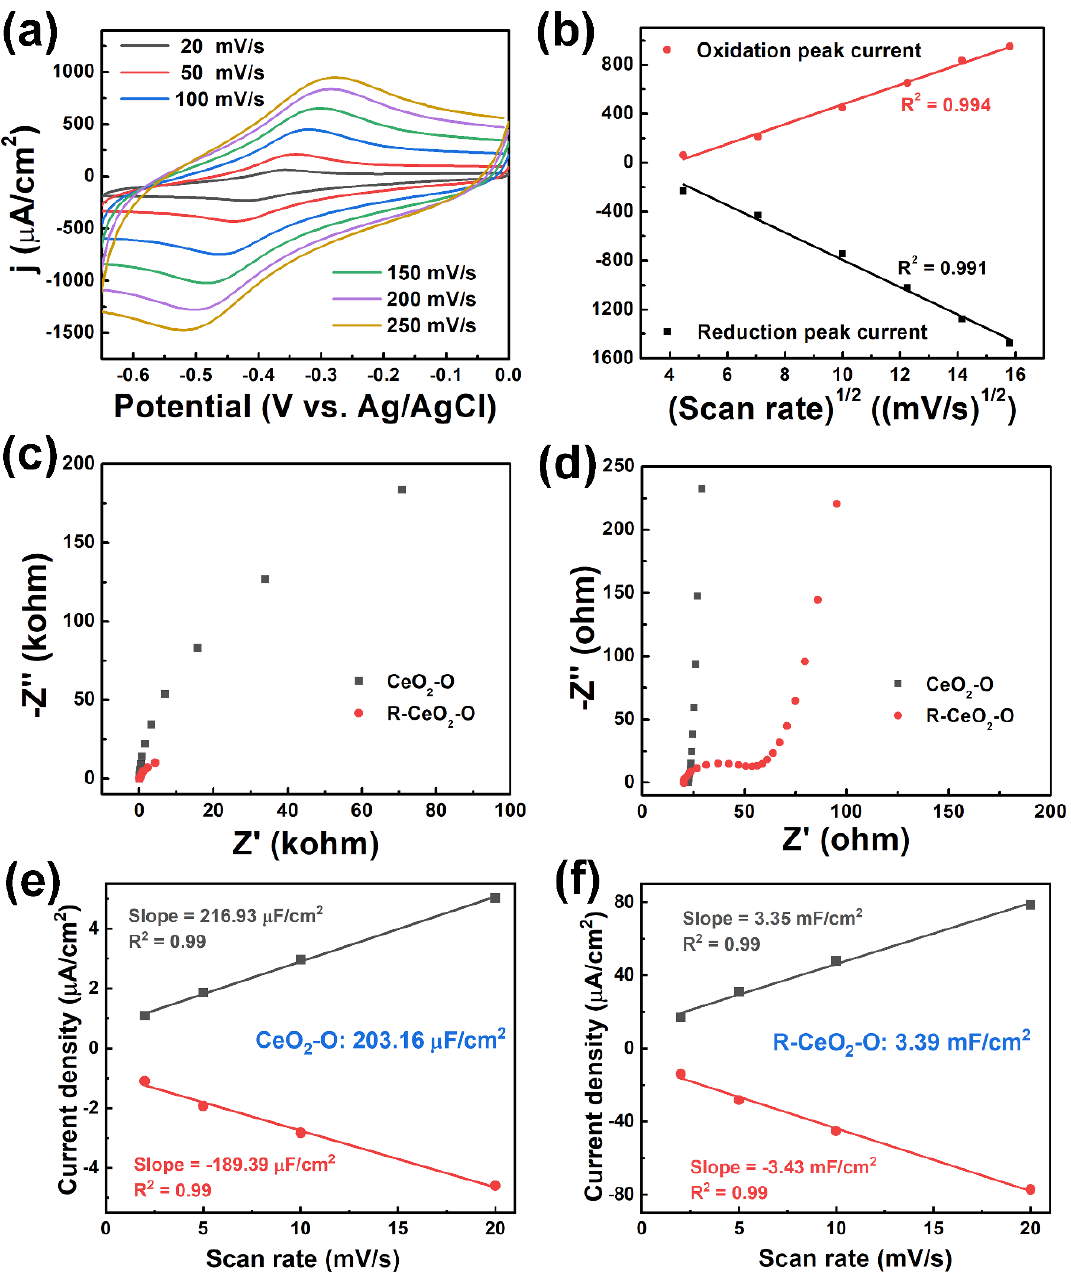
Figure 5. ( a ) CV scans of R-CeO 2 -O in 0.1 M PBS with 1 mM H 2 O 2 at different scan rate and ( b ) linear plots of peak current density versus square root of scan rate. Nyquist plots of CeO 2 -O and R-CeO 2 -O ( c ) in full range and ( d ) in high-frequency region. The corresponding linear plot (derived from Figure S6) of the capacitive currents of ( e ) CeO 2 -O and ( f ) R-CeO 2 -O vs. scan rates for EASA calcu- lation.